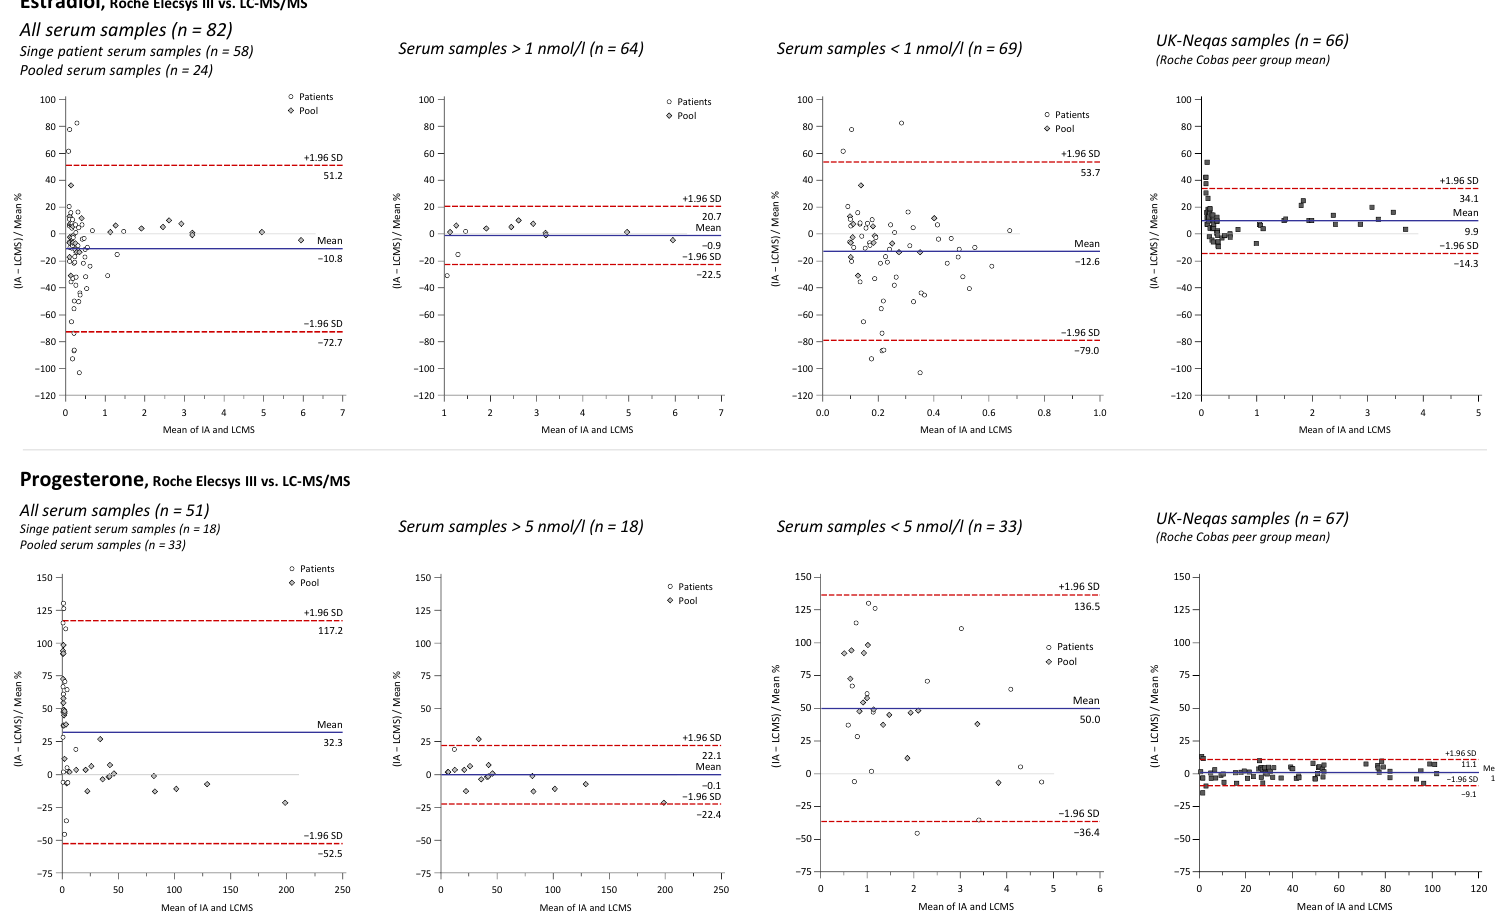
Figure 7. Bland and Altman plots comparing measurement results of the LC-MS/MS (LCMS) method and in-house immunoassays (IA) for analytes estradiol and progesterone differentiating between single patient serum samples (circles), pooled serum samples (diamonds), and UK NEQAS proficiency testing samples (squares). x -axis: mean of IA and LC-MS results in nmol/L; y -axis: difference between both measurements in % of the mean of both methods.